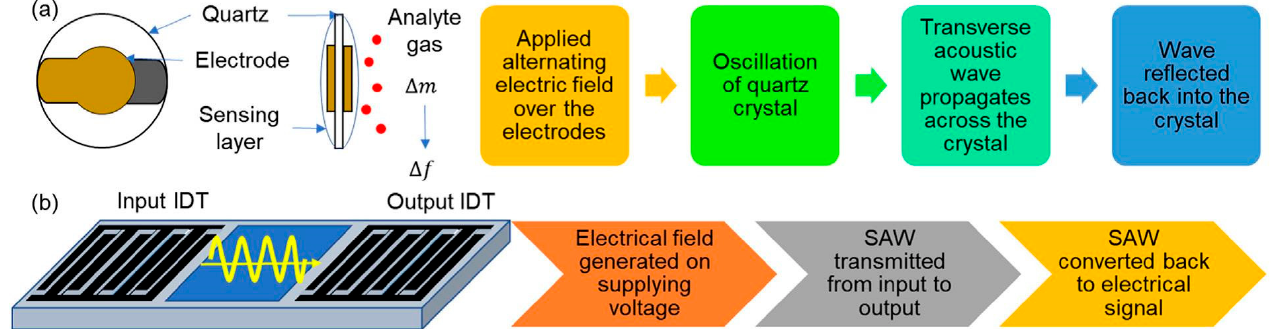
Figure 11. Representation of the sensing mechanism of gas detection using ( a ) a QCM sensor where the oscillation of the quartz crystal substrate and propagation of the transverse acoustic wave through the quartz substrate are caused by the alternating electric field applied over the electrodes; sensing layer-gas interactions change the mass on the substrate and hence wave amplitude and velocity, leading to a resonance frequency shift ( Δ m → Δ f); ( b ) SAW sensors where a surface wave confined within one acoustic wavelength of the surface of the piezoelectric material is induced by an input RF-voltage applied across the interdigitated transmitter (IDT); mechanical energy is transformed back into radio frequency as an output when the SAW reaches the receiving IDTs. Αnalyte adsorption on the piezoelectric coating induces mass variations and ultimately a shift in frequency. Reprinted with permission from Ref. [172]. Copyright © 2021 Elsevier B.V. All rights reserved.